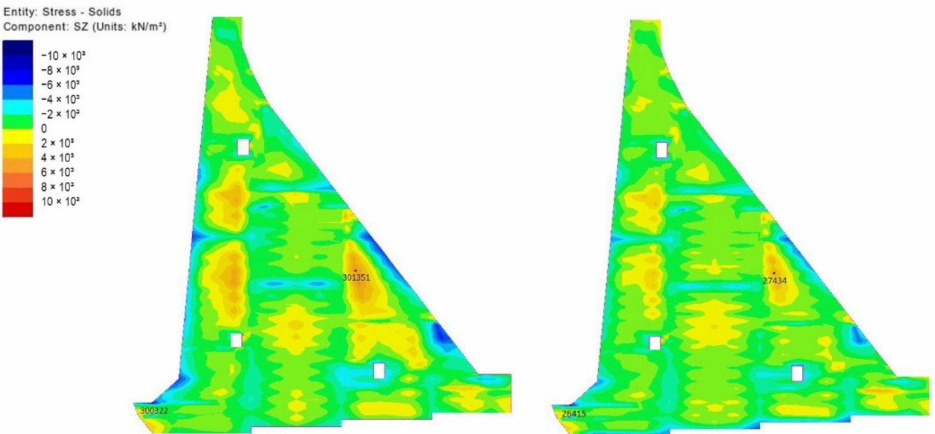
Figure 23. Stresses σ z in the mid-plane of the monolith 20 m long ( left ) and 15 m long ( right ) for the 1804th day (25th of September of the sixth year); extremums: nodes 301,351 and